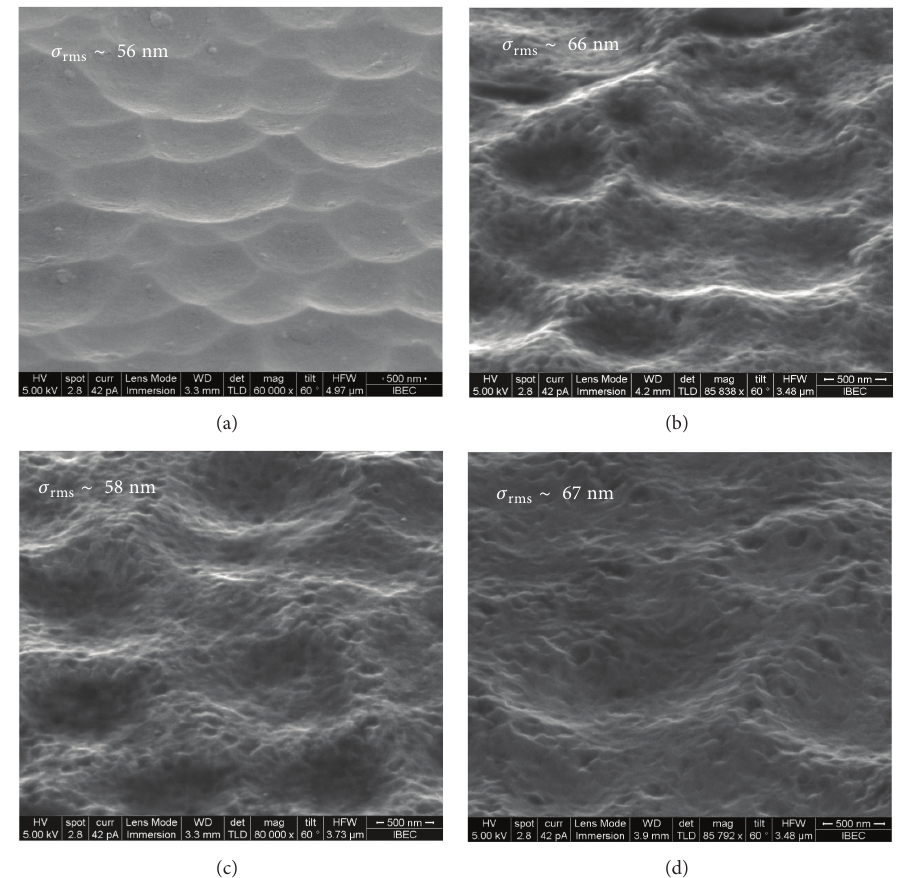
Figure 4: HRSEM (tilted at 60 ∘ ) micrographs of (a) texture E, (b) E + AZO1 (500nm), (c) E + AZO2 (700 nm), and (d) E + AZO3 (1000nm). values were obtained from The 𝜎 rms